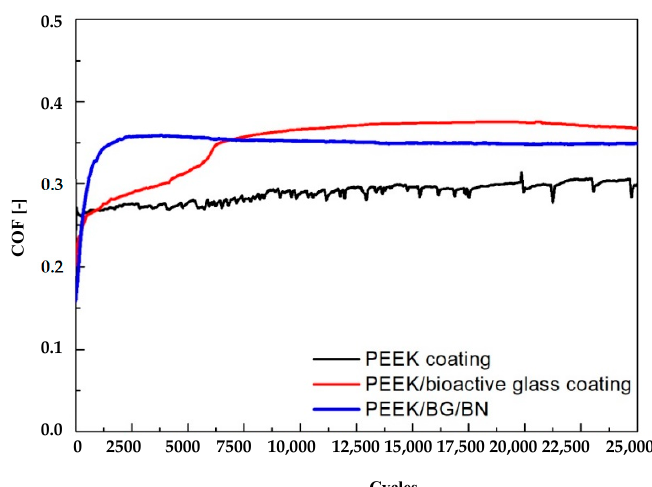
6 of 19 Figure 1. PEEK/BG/h-BN coatings produced by EPD at a voltage of 90 V for 90 s and sintered at 375 °C; ( A ) SEM image of the top surface, ( B ) EDX mapping at the cross-section, ( C ) SEM image at a cross- section, and ( D ) EDX analysis. In our previous studies [5], PEEK/BG/h-BN coatings showed a convenient wetting behavior and good adhesion strength to stainless steel substrates. Moreover, the produced coatings were bioactive according to SBF studies [5]. The wear behavior of the coatings was investigated in the present study, given the relevance of this property for applications in orthopedic implants [12]. Wear refers to the deformation of materials during the mechanical process of relative motion between two or more contacting surfaces, which causes the surface to degrade. The surface of the implanted device can wear out, and this can primarily affect joint prosthesis [43]. Therefore, h-BN can be conveniently used, exploiting its layered (lubricating) structure, in combination with polymeric biomaterials to impart self-lubrication properties and wear resistance to the coatings. In Figure 2, the results of wear tests under dry sliding conditions at a load of 7 N against alumina balls on PEEK, PEEK/BG, and PEEK/BG/h-BN coatings are presented. Throughout the whole span of the test, the friction behavior of all materials was stable. Afterward, the coefficient of friction (COF) remained stable for PEEK/BG and PEEK/BG/h-BN coatings. Few oscillations in the coefficient of friction of PEEK coatings were observed, which could be due to the nonuniform wear track in PEEK [44,45], as shown in confocal microscope images (Figure 3). The oscillations in the wear test of PEEK coatings were repeated with each revolution of the disc. Moreover, with an increase in the number of cycles, the amplitude of oscillations changed (Figure 3). However, COF remained stable over the sliding distance of 750 m. The results, thus, indicate that PEEK/BG/h-BN coatings sintered at 375 °C